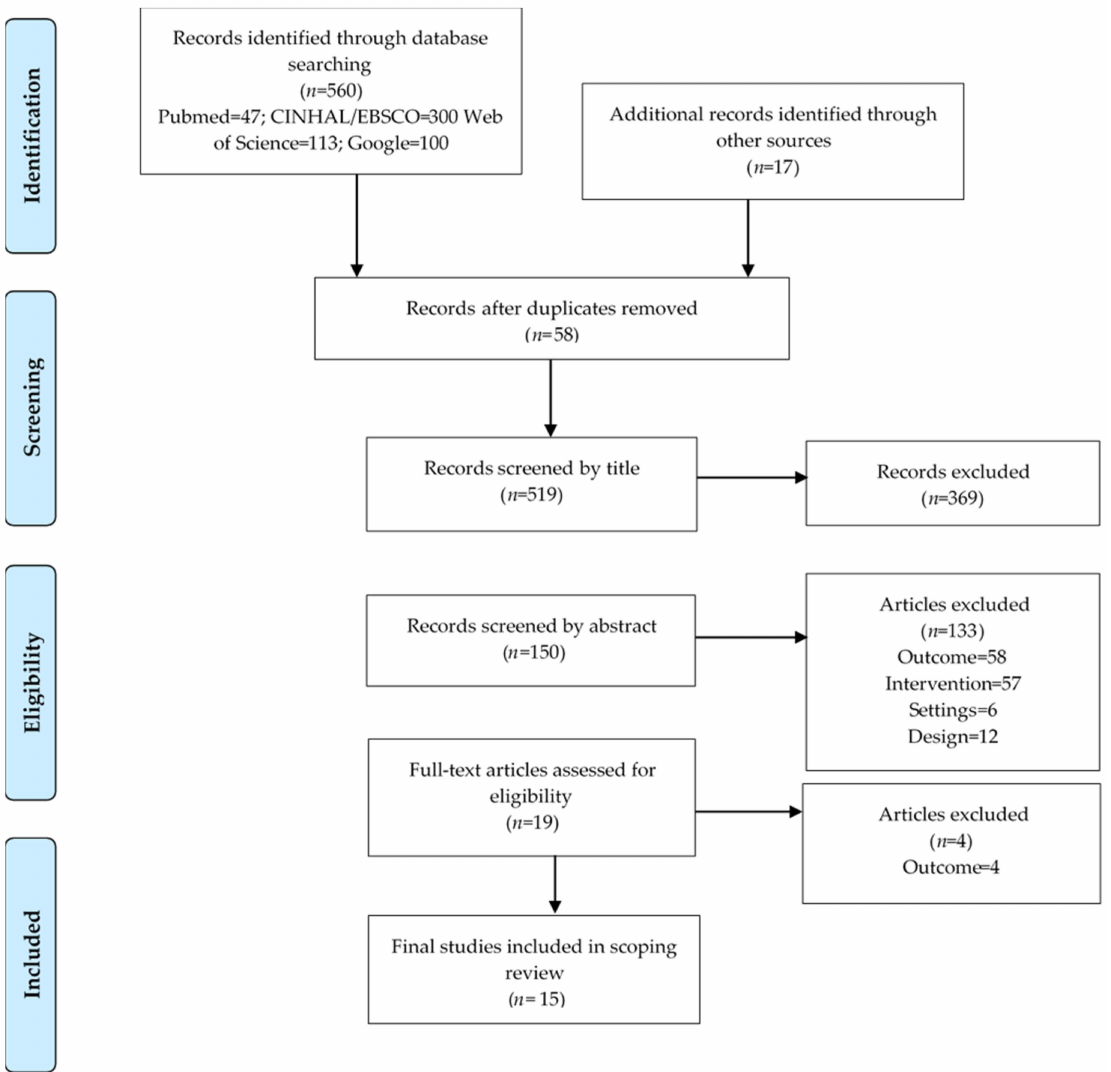
Figure 1. PRISMA flow diagram of the systematic study identification, screening, and selection of the studies for the scoping